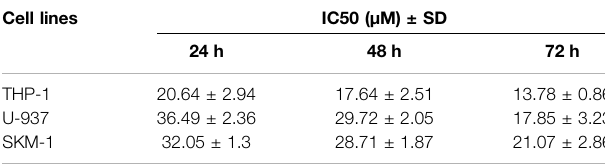
TABLE 1 | IC50 Values of Honokiol on AML cell lines. Cell